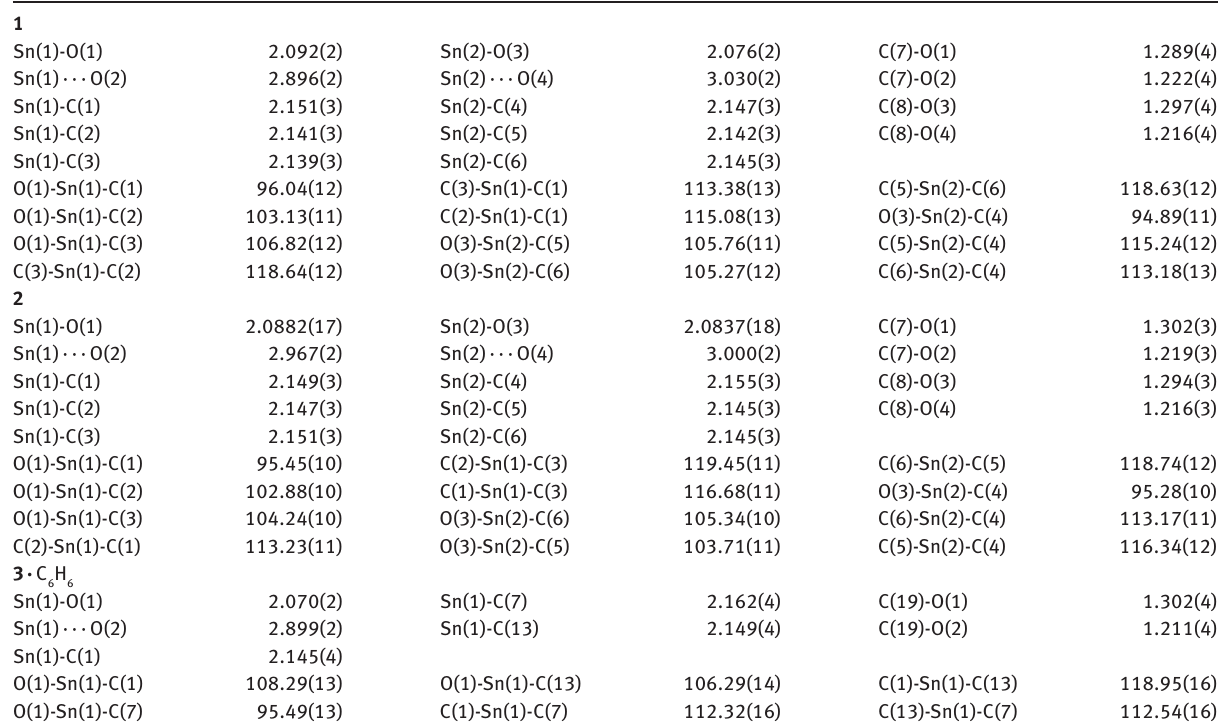
Table 1: Selected bond lengths (Å) and angles ( ° ) for 1–3